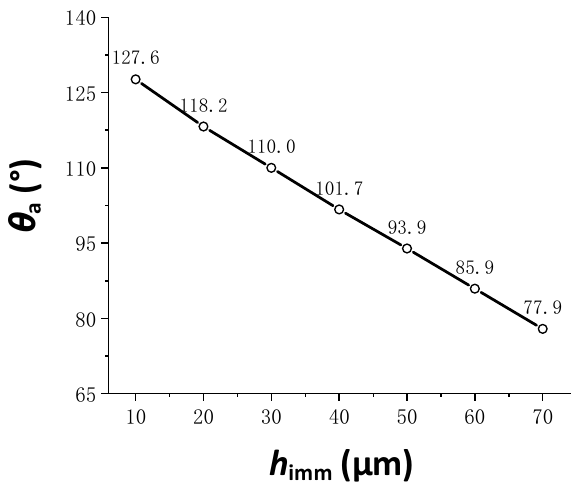
Figure 4. The relationship between the apparent contact angle and droplet infiltration depth. The microstructure array processing tool is a diamond tip with a tip angle of 90°, then θ T = 90°, and the relationship between the width of the processed microstructure and the depth of the microstructure is w = 2 h . Therefore, different microstructure morpholo- gies can be obtained by setting different h and p . When the microstructure depth h is fixed, the influence of the microstructure pitch p on the wettability of the coating surface is studied. Using the composite infiltration model, we set h to 8 μ m, and calculated the relationship between the free energy of the